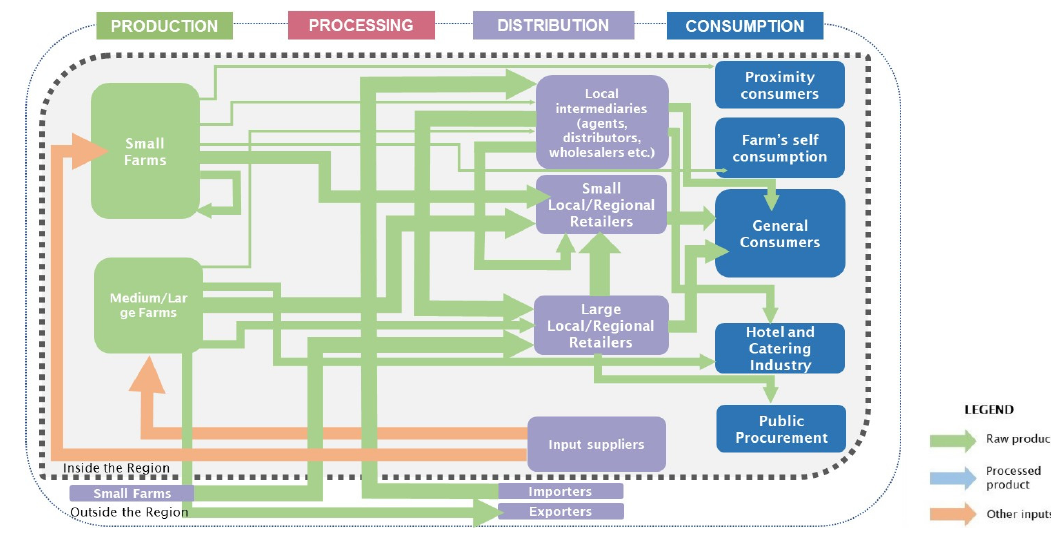
Figure 6. Regional food system for chicken.